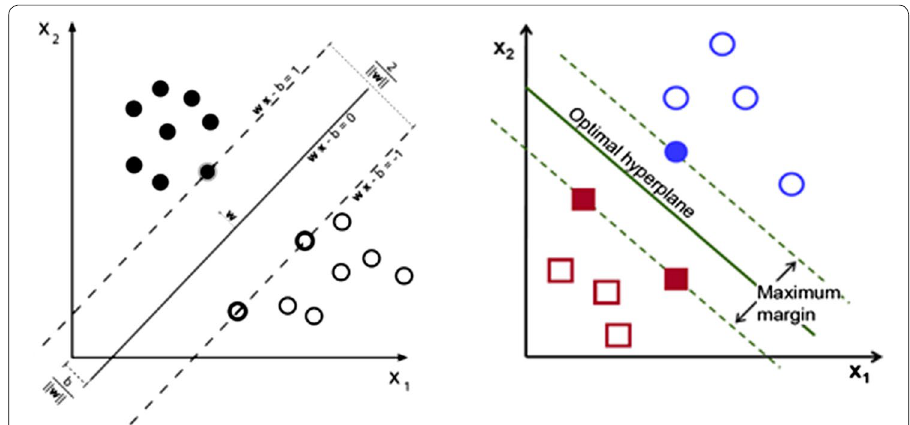
Fig. 4 SVM hyperplane. SVM Hyperplane is separate the data into two